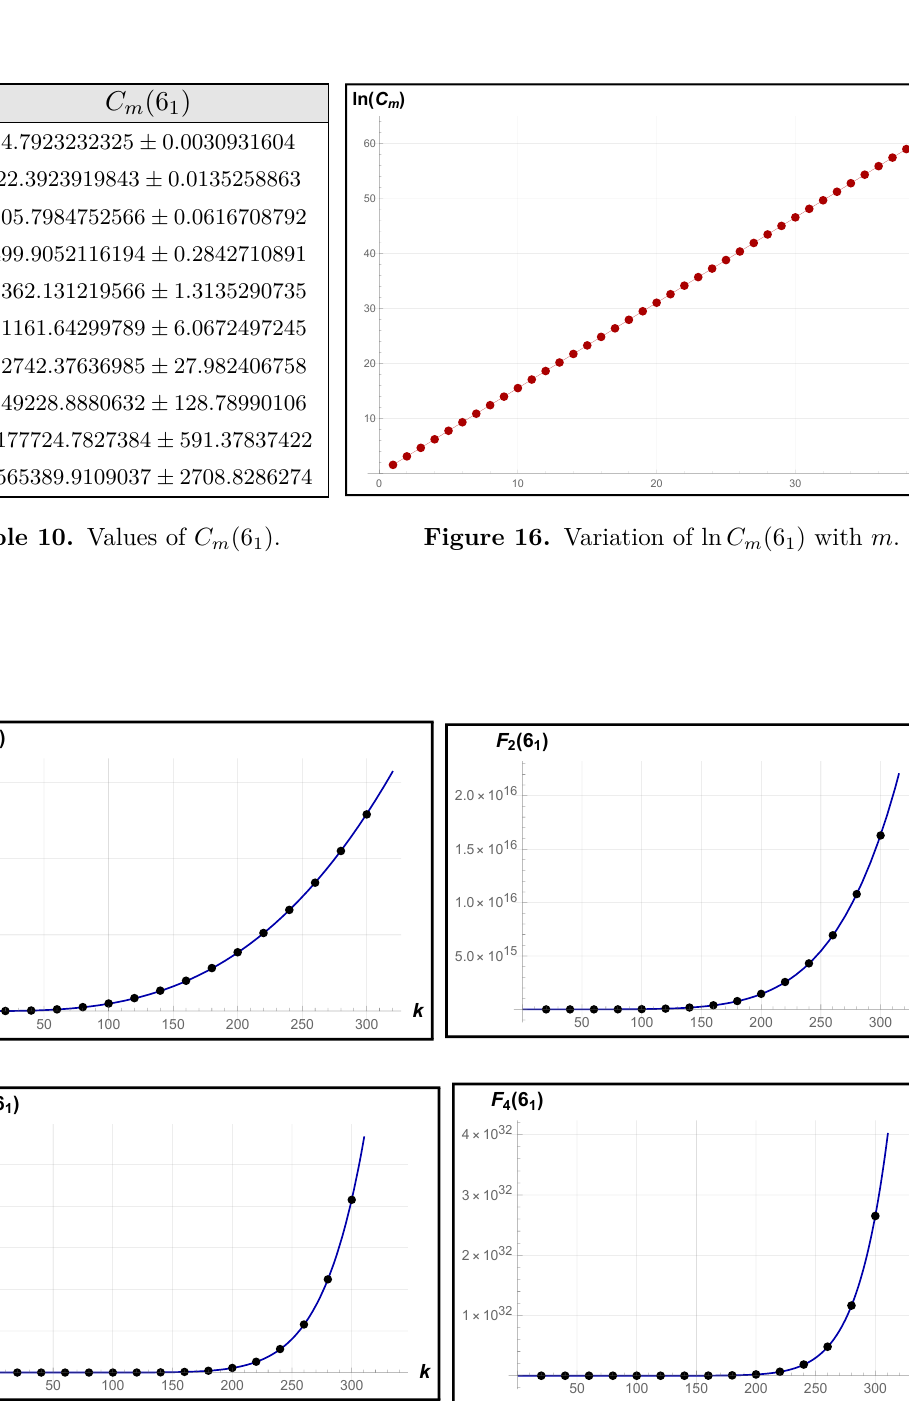
Figure 17. The variation of the function F m with k for 6 1 knot. The solid line denotes the function C m k 3 m with values of C m given in table 10. The • indicates the numerical values of F m obtained from explicit